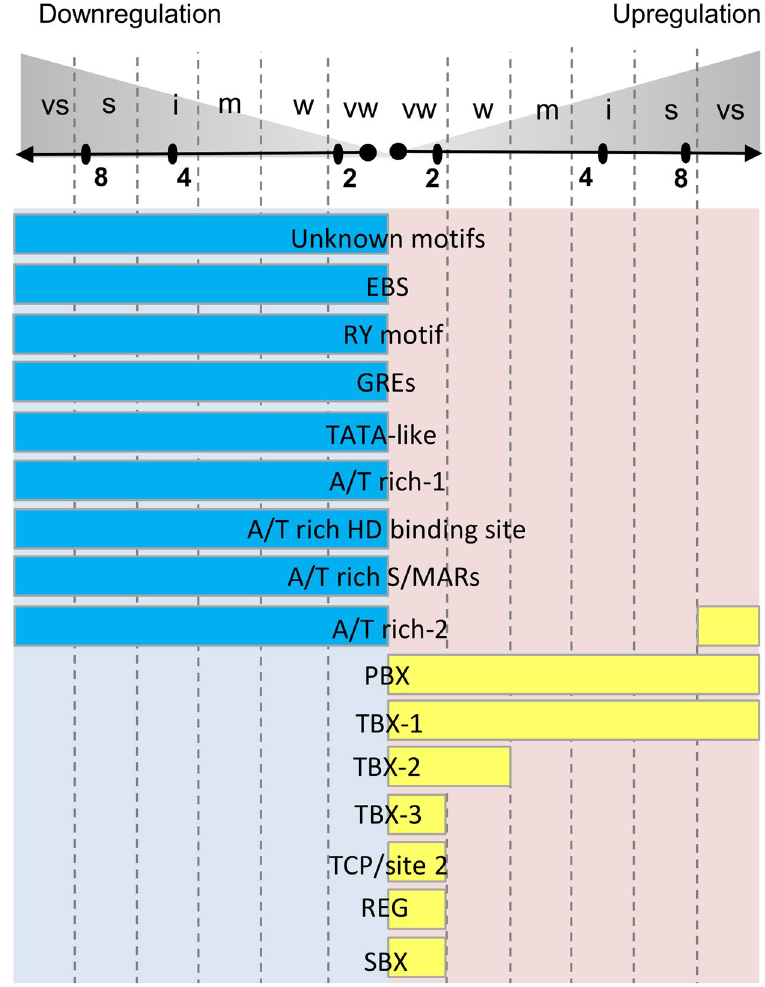
Figure 7. cis-Regulatory motifs found enriched in the upstream regions of the genes responded to auxin within certain fold change intervals. Unknown motifs (atacta/tagtat, atagta/tactat; atatga/tcatat, atatgt/acatat, taatag/ ctatta, tatgta/tacata); EIN3-binding site EBS (atacat/atgtat) 30 ; B3-family binding RY motif (tgcatg/catgca) 31 ; bZIP-binding GRE/ABRE motifs (tacgtg/cacgta; acacgt/acgtgt, acgtgg/ccacgt) 32 , TATA-like (aatata/tatatt, actata/tatagt, atataa/ttatat, atatac/gtatat, atatag/ctatat, tataac/gttata, tatata, tatatg/catata; atatat) 33 ; A/T rich-1 (aataat/attatt, aattat/ataatt, ataata/tattat, attaat, attata/tataat, taaata/tattta, tattaa/ttaata); A/T-rich Homeodomain (HD) binding site (taatta) 34 ; A/T-rich S/MARs (aatatt) 35 ; A/T rich-2 (atatta/taatat); PBX (atgggc/gcccat); TBX-1 (ttaggg/ccctaa), TBX-2 (aaccct/agggtt, acccta/tagggt), TBX-3 (aaaccc/gggttt, ctaggg/ccctag, SBX (aagccc/gggctt) 17 ; TCP/site2 16, 21 (agccca/tgggct, tgggcc/ggccca); REG (aggccc/gggcct) 17, 18 . For more detailed descriptions see Supplementary Table